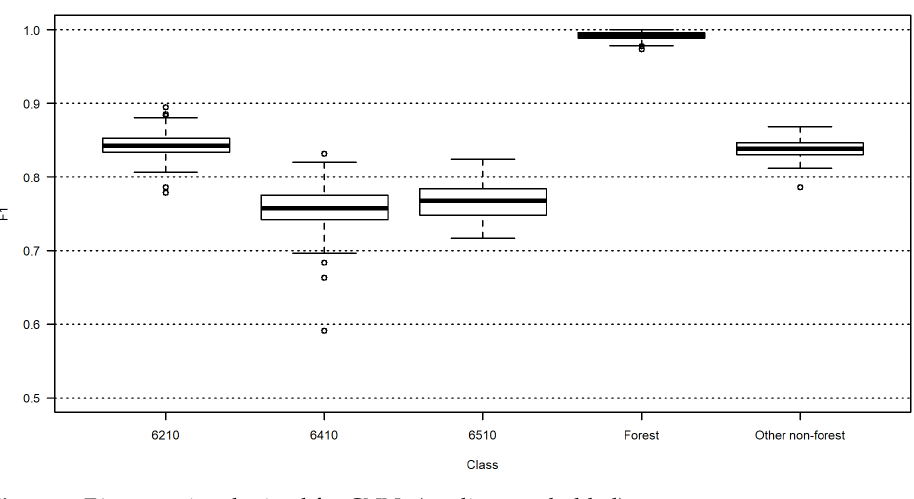
We obtained more diverse results for individual classes, and we focused more on F1